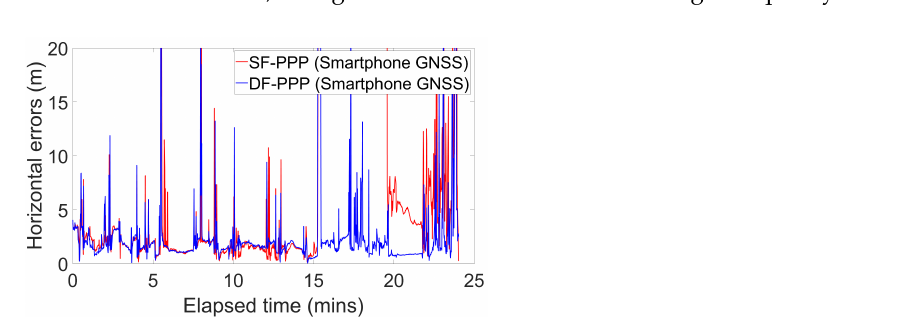
Figure 9. Horizontal error with respect to the reference trajectory for single-frequency PPP and dual-frequency PPP processing with same